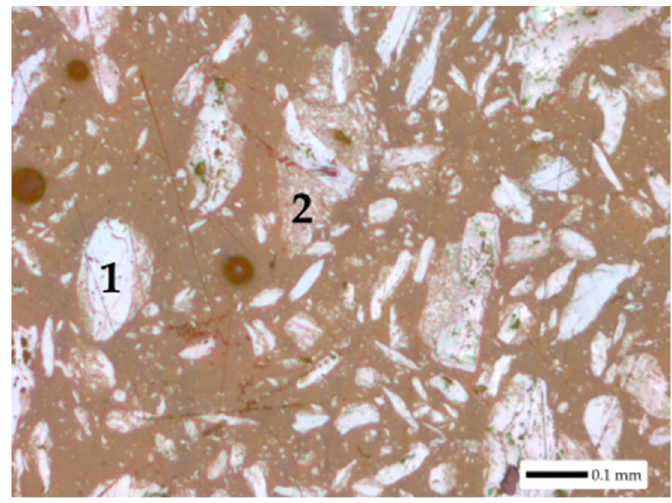
Figure 4. X Microphotograph of the condensate: (1) auripigment; (2) realgar.